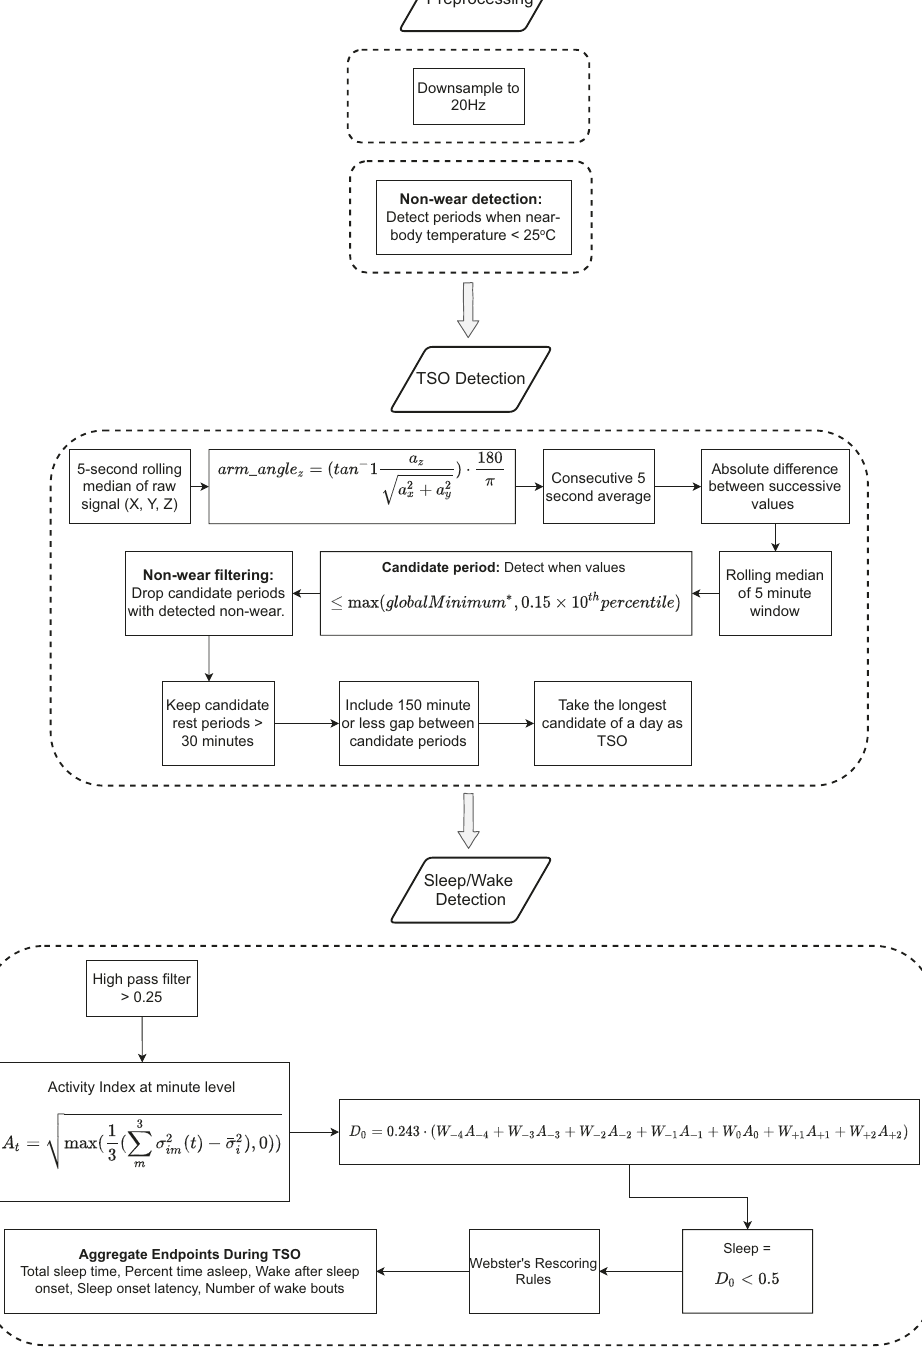
Fig. 4 Overview of the sleep module processing pipeline. The pipeline consists of data preprocessing, total sleep opportunity (TSO) and wear detection, sleep/wake classi fi cation, and sleep assessment. *Global minimum is set to 0.1 based on the 25th percentile value of all valid (on-body) data (see Supplementary Fig. 7). Block with a dashed outline provides a detailed illustration of steps in the preceding block with a solid which were not available for the wearable device used in this study. Therefore, an open-source activity index metric 32 was used as a proxy for activity counts in our implementation. Webster ’ s rescoring rules were applied to the binary sleep – wake predictions to improve speci fi city 11 . Digital measures of sleep were derived for each 24-h segment by processing the sleep – wake predictions during the determined TSO window as seen in Table 4.